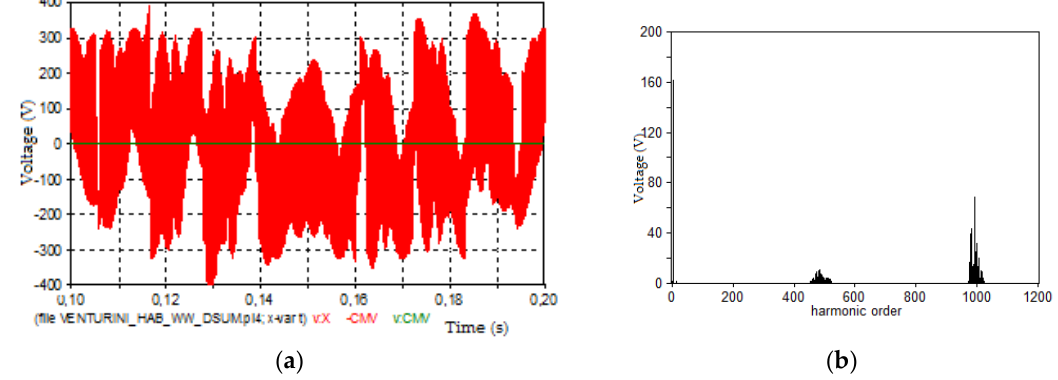
Figure 5. Waveforms of the output voltages (red lines) and CMV (green lines) ( a ) and Fourier analysis of the output voltage ( b ), synthesized in MMC and controlled by the use of CCW rotating space vectors, for the angle ψ = 0 ◦ and output frequency of 80 Hz.